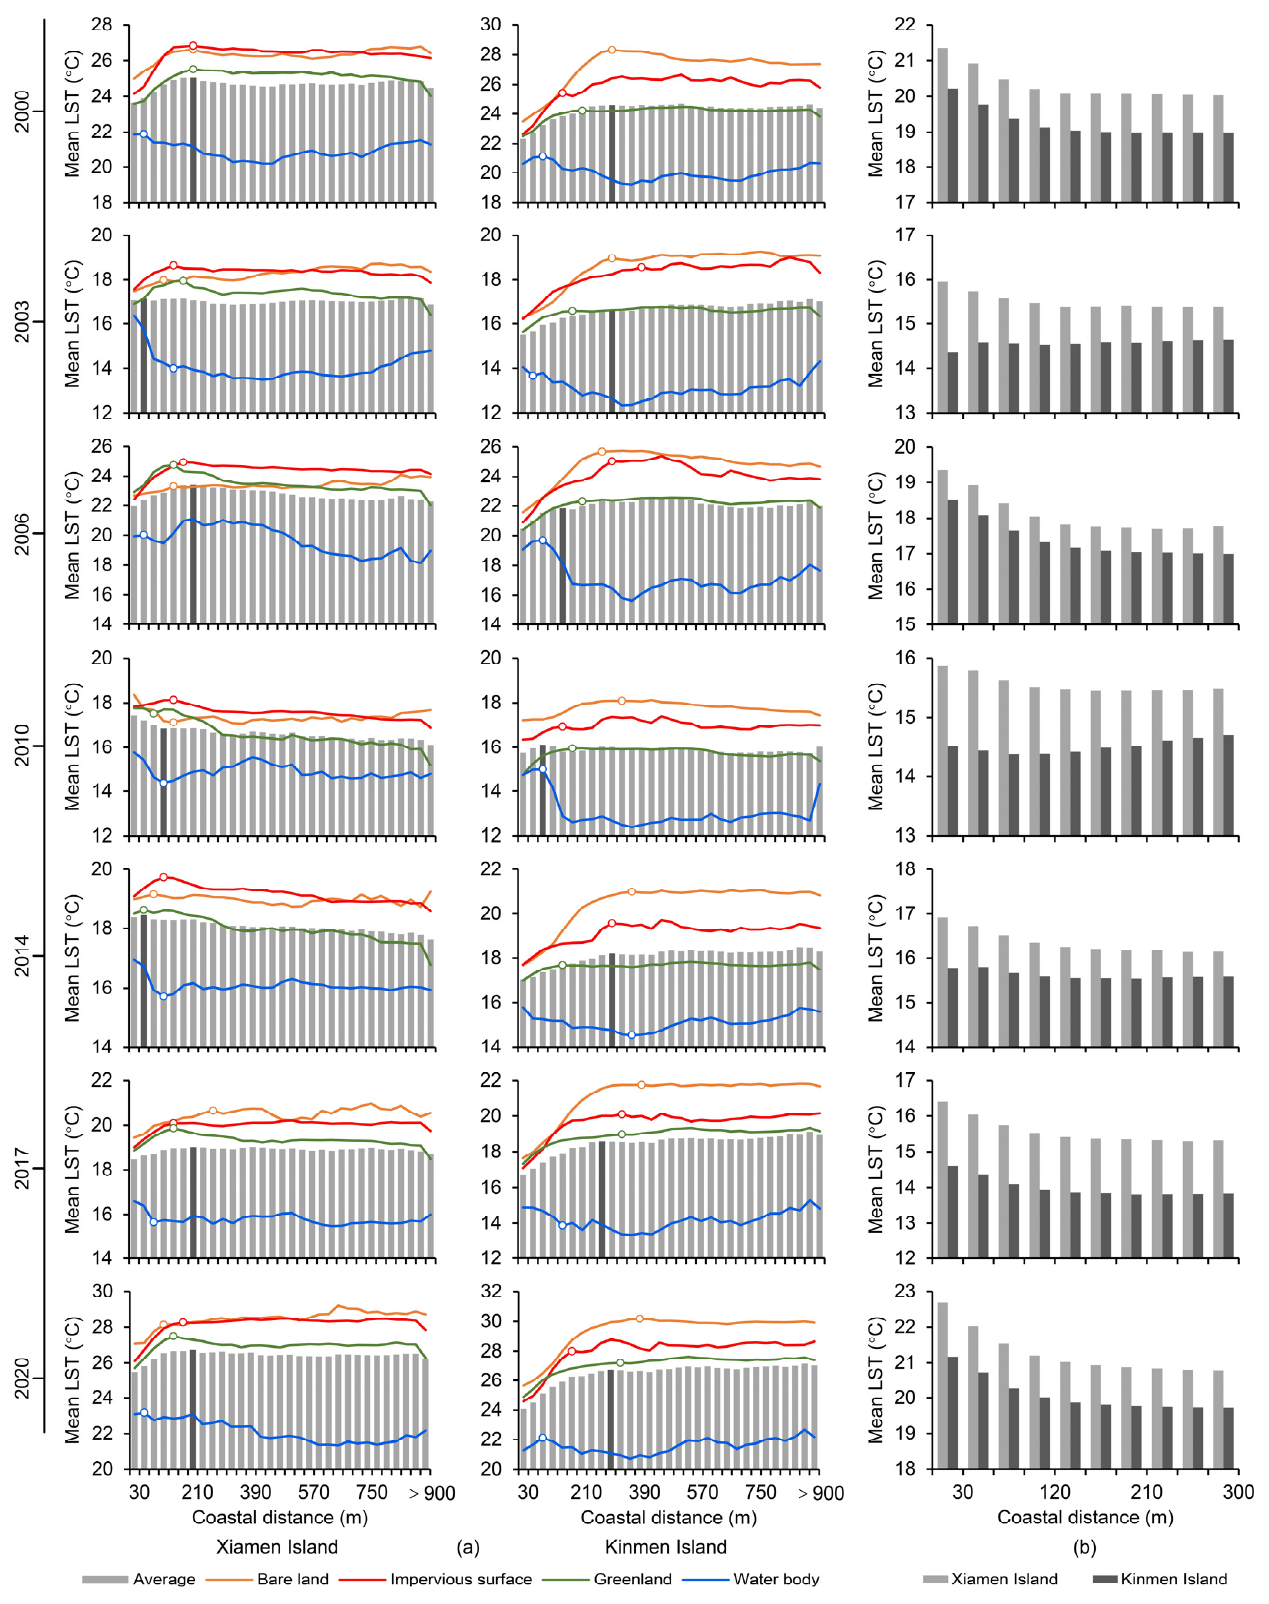
Figure 6. Variation of mean LST with coastal distance in the two islands from 2000 to 2020. ( a ) Mean LST of various land types at different coastal distances based on a 30 m distance resolution; ( b ) Comparison of mean LST of seawater at different coastal distances.